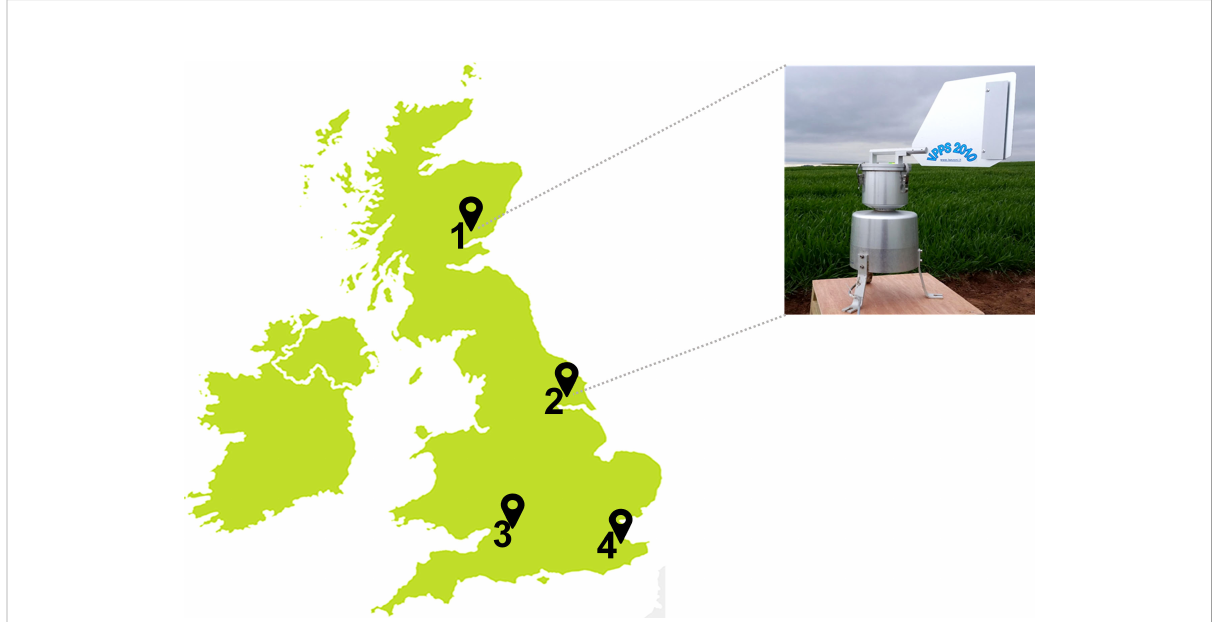
FIGURE 1 UK spore traps locations at wheat fi elds in: (1) Carnoustie, Angus (North-East); (2) Bishop Burton, Yorkshire (Central-East); (3) Swindon, Wiltshire (South-West); and (4) Lenham, Kent (South-East). Volumetric Pollen and Particle Sampler, VPPS ® 2010 by LANZONI srl in Carnoustie and Bishop Burton; Seven-Day Recording Volumetric Spore Trap by © Burkard Manufacturing Co Ltd in Swindon and